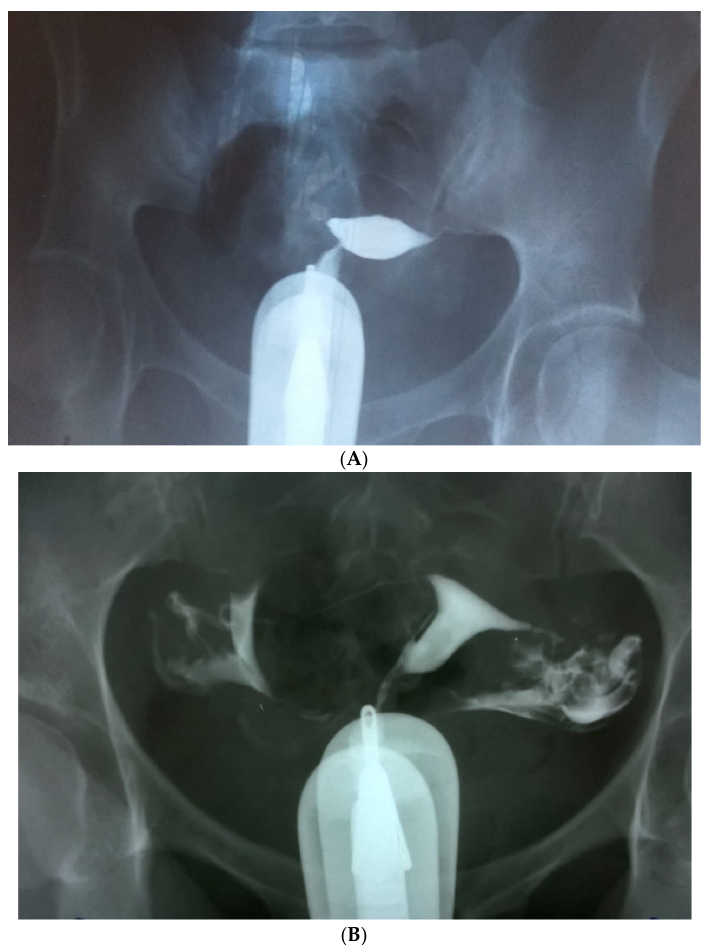
Figure 3. ( A ). Fallopian tube ligated in the cervix-isthmus junction on both sides, after tubal